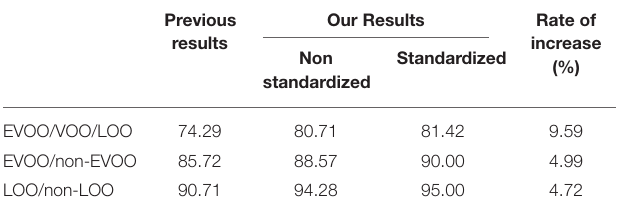
TABLE 2 | Results obtained for 2014–2016 harvests. TABLE 3 | Accuracy comparison with other methods for 2014–2016 (D1-D2)